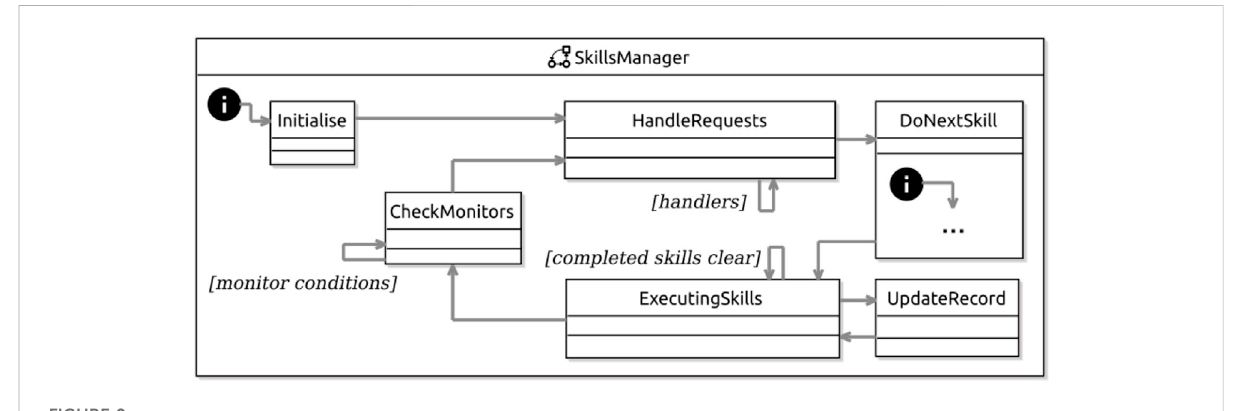
FIGURE 9 RoboChart skills-manager machine for the